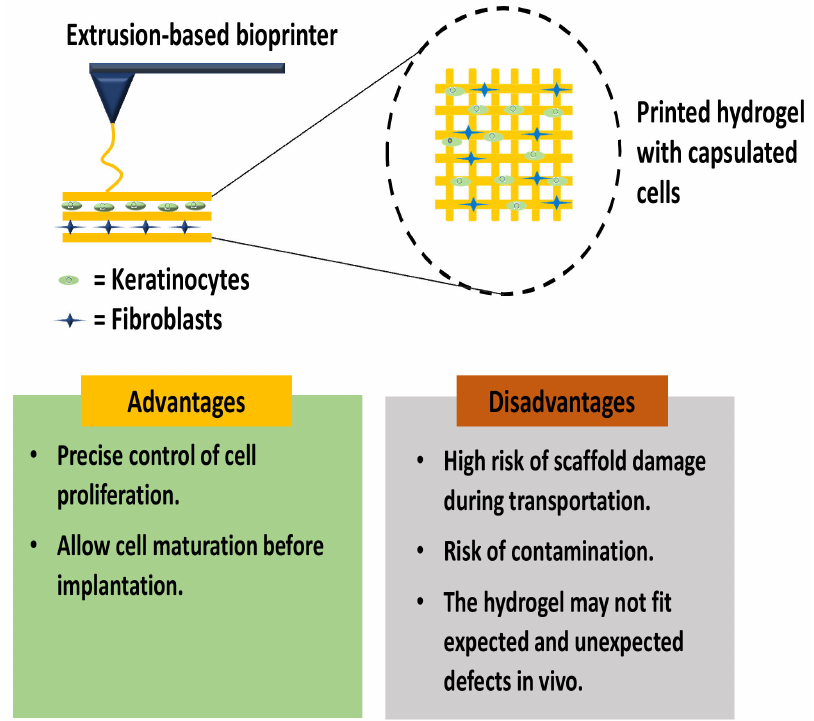
Figure 5. In vitro 3D-bioprinting using extrusion-based